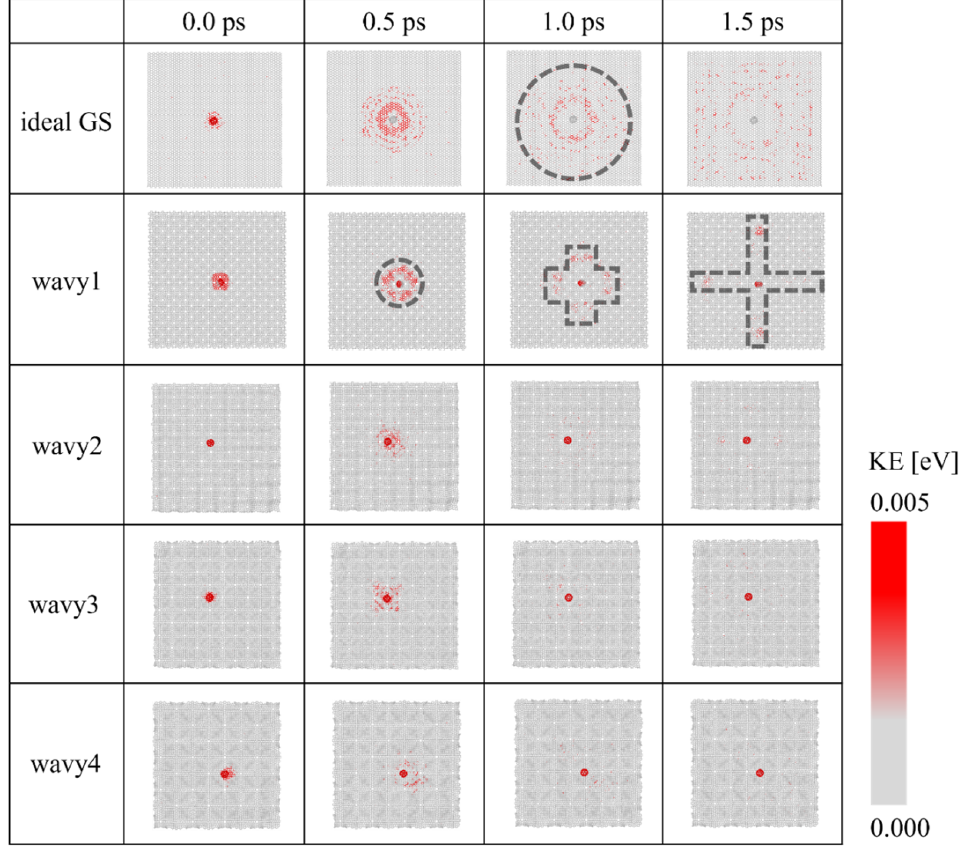
Figure 5. Time evolutions of KE distributions of the GS models impacted by C 60 with an initial velocity v 0 of 10 Å/ps. The distributions at 0, 0.5, 1.0, and 1.5 ps were computed based on the moment of impact corresponding to 0 ps.